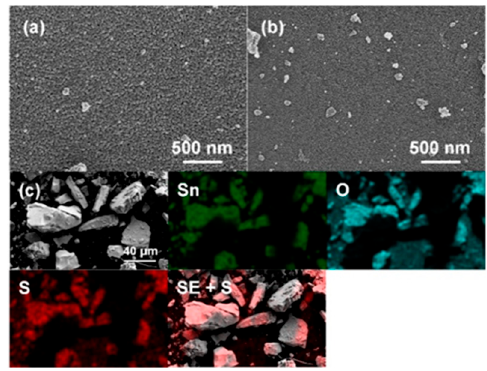
Figure 1. Field-emission scanning electron microscopy (FE-SEM) images of the surface of ( a ) intact SnO 2 ; and ( b ) SO 42 − /SnO 2 ; ( c ) SEM-energy dispersive X-ray spectroscopy (EDS) elemental mapping images of SO 42 − /SnO 2 . The samples were prepared by calcination at 550 °C for 4 h. In the overlay image of SEM and sulfur atom mapping, the gray color represents an area in shadow or surface facing away from the EDS detector.